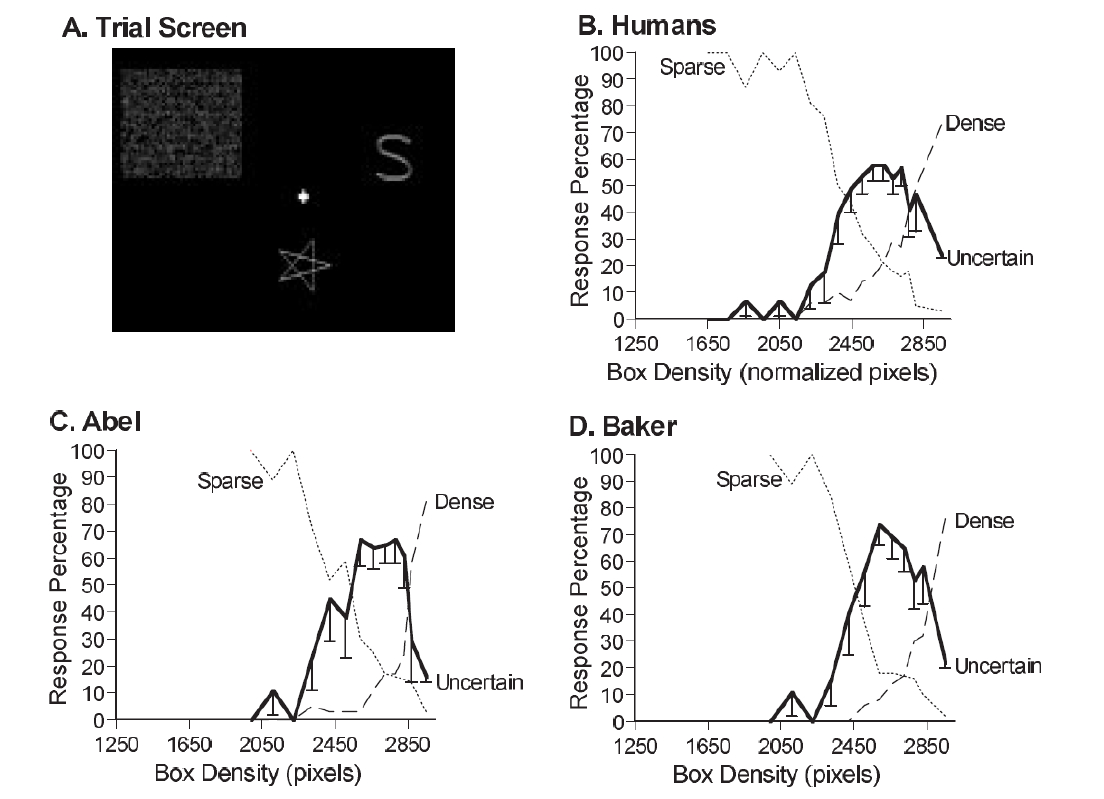
Figure 1 . A. An example trial in the dense-sparse discrimination task given to humans and to monkeys. B. The performance of seven humans in the dense-sparse task. The dense response was correct for boxes with exactly 2,950 pixels – these trials are shown at the far right. All other boxes required the sparse response. The horizontal axis indicates the normalized pixel-density of the box. The solid line represents the percentage of trials receiving the Uncertain response at each density level. The percentages of trials ending with the dense response (dashed line) or sparse response (dotted line) are also shown. C. The performance of one monkey named Abel in this task. D. The performance of another monkey, Baker, in this task. From “The Comparative Psychology of Uncertainty Monitoring and Metacognition,” by J. D. Smith, W. E. Shields, and D. A. Washburn, 2003, Behavioral and Brain Sciences, 26, p. 322. Copyright 2003 by the Cambridge University Press. Reprinted with